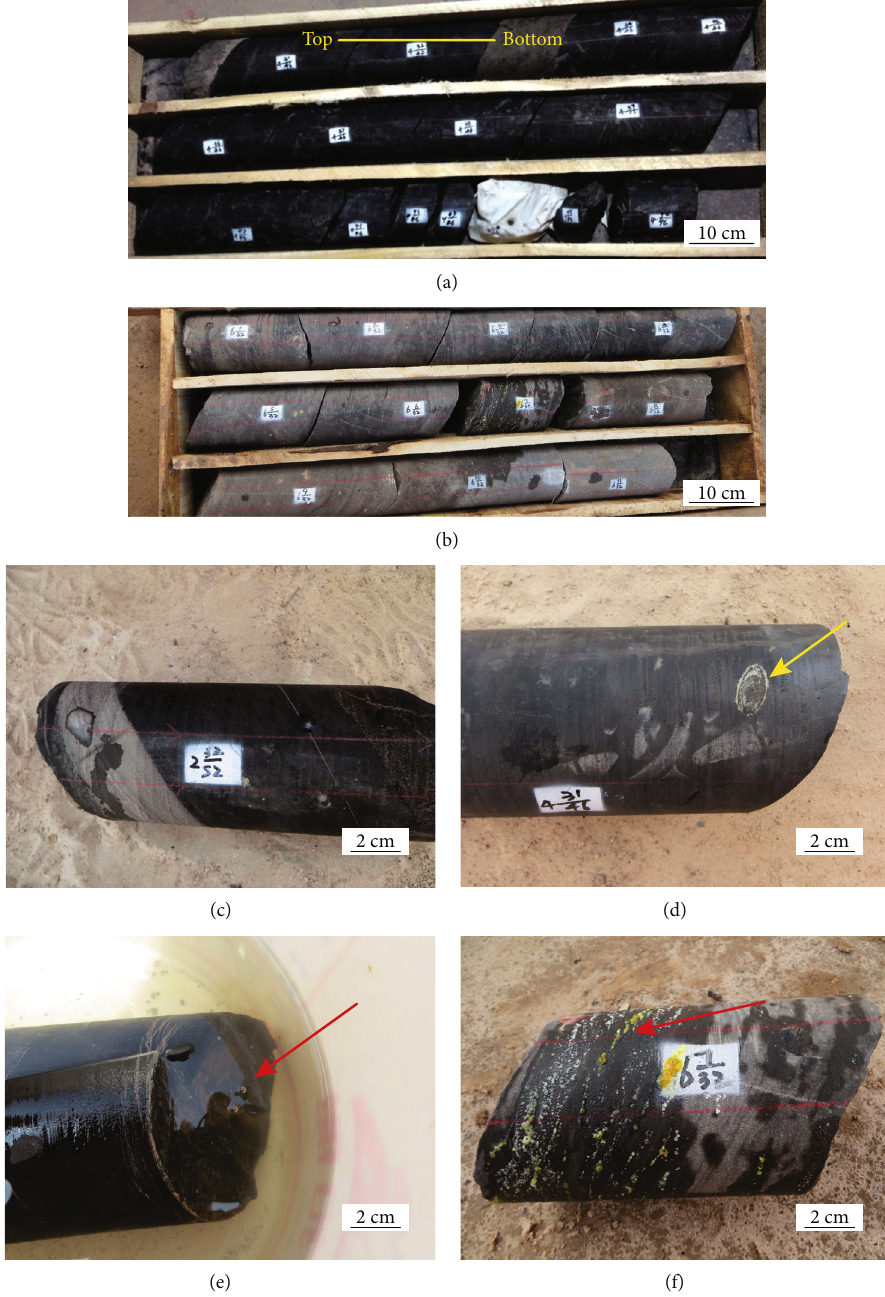
Figure 3: Photographs of core from Chang 8 to Chang 7 3 intervals in well DP1. (a) Dark shale interbedded with fi ne sandstone in the 1 st to 5 th roundtrips. (b) Gray medium – fi ne sandstone in the 6 th roundtrip. (c) Fine sandstone in the 2 nd roundtrip. (d) Pyrite nodules in the 4 th roundtrip. (e) Air bubbles occurred in water from the 5 th roundtrip. (F) Yellow crude oil seeped in the 6 th roundtrip. Note that the yellow arrow in (a) indicates the bottom and top of the drilling